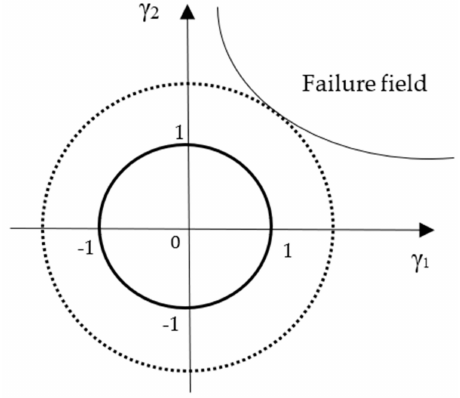
Figure 8. Non-probabilistic reliability index of the standard space ellipsoid